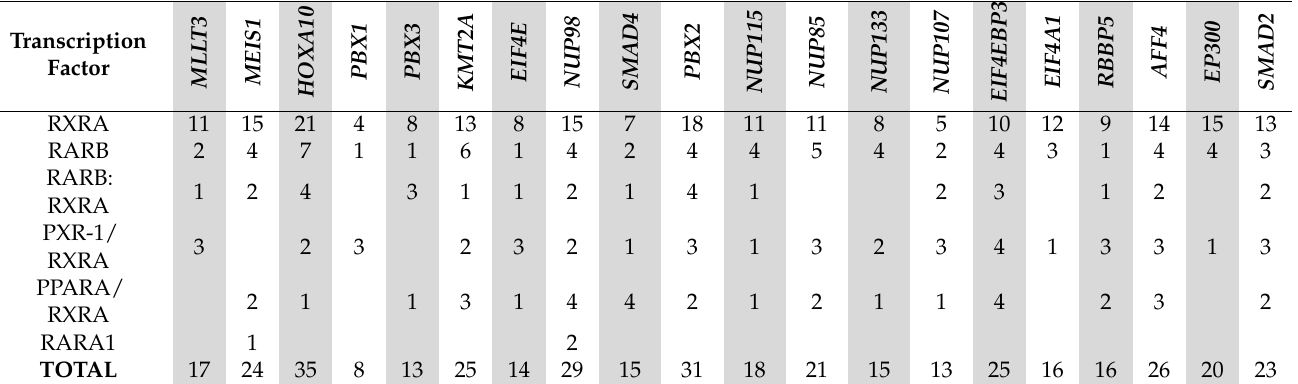
Table 3. List of RAR and RXR binding sites in the promoter of genes classified as being transcription- ally dysregulated in cancer and functionally associated with